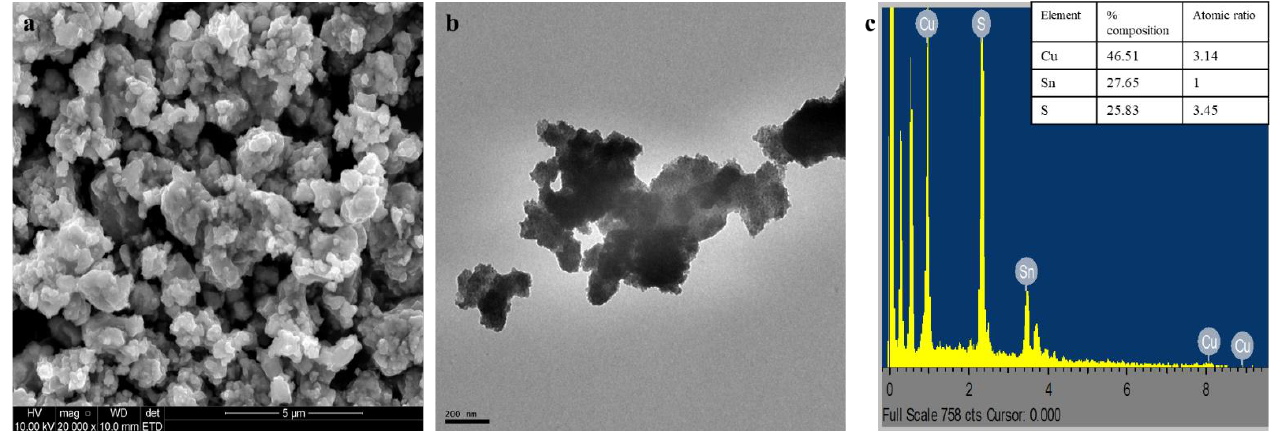
Figure 3. ( a ) SEM, ( b ) TEM, and ( c ) EDS images of CTS. The absorption spectra and the corresponding Tauc plots (insets) of PCN, GO, CTS, GO-CTS, PCN-CTS, and PCN/GO-CTS are shown in Figure 4a – f, respectively. The spectrum of PCN showed an absorption maximum edge at 302 nm, with the absorption tailing into the visible region. This tailing of the absorption may be attributed to the formation of band tail states, which has been reported to be due to the presence of N-defects in PCN [42]. The absorption spectrum of GO showed a very sharp absorption edge at about 303 nm, with the absorption falling almost immediately to zero. The calculated band gap for PCN and GO was 2.91 and 2.51 eV, respectively, which is in agreement with the values in the literature [42,43]. CTS showed two significant absorption bands at 312 and 418 nm, with the absorption intensity remaining significantly strong into the visible region. The three composites showed significant differences in their absorption spectra, indicating a difference in the influence exerted on the electronic structure of CTS by GO, PCN, and PCN/GO. In PCN-CTS, a blue shift of the band at 312 nm to 318 nm and broader bands were observed compared to pristine CTS. The absorption tails into the visible region were also reduced compared to CTS. For the GO-CTS, the absorption spectrum was also significantly influenced when compared to CTS. The absorption maximum was observed at 305 nm, which was closer to the value for GO and also very sharp. The absorption was also reduced significantly as it tailed into the visible region. The absorption spectra of PCN/CTS-GO showed a broad band at 305 nm, which could be attributed to GO. However, the absorption remained relatively strong into the visible region. A new absorption band was also observable at about 950 nm, and this could suggest the possible formation of new intra-band states in PCN/GO-CTS. The evaluated band gap for CTS, PCN-CTS, GO-CTS, and PCN/GO-CTS was 1.65, 1.46, 1.43, and 1.16 eV, respectively. Thus, a red shift to lower energy was observed by the incorporation of PCN and GO into CTS and the red shift was significantly enhanced by the incorporation of both PCN and GO.